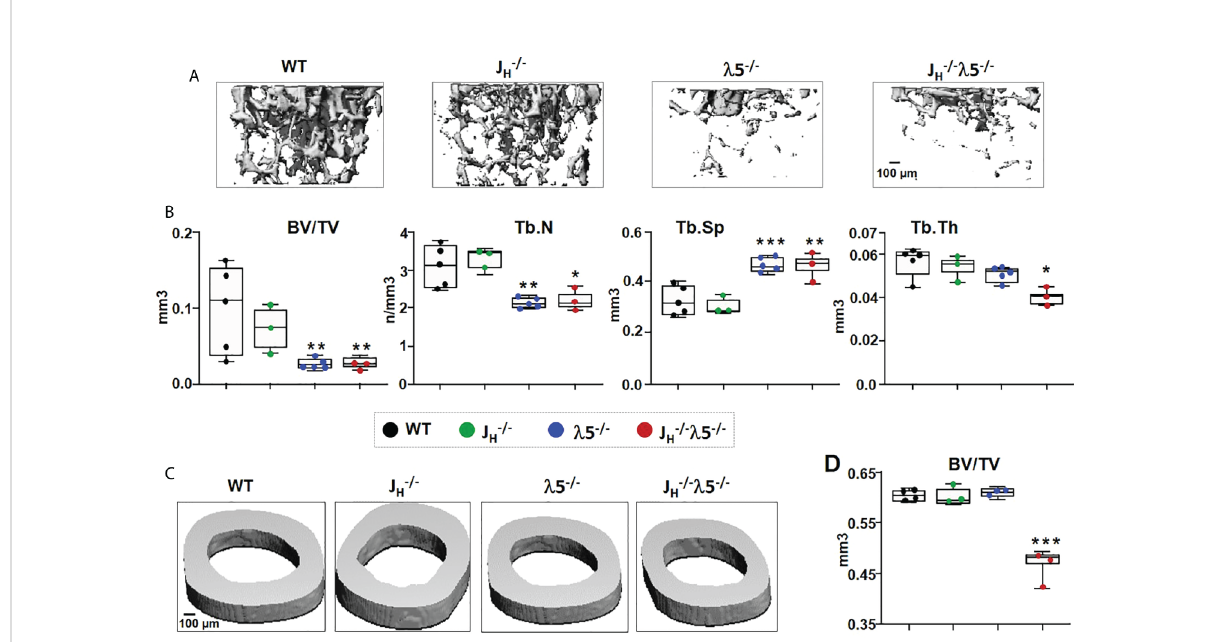
FIGURE 1 De fi ciency of l 5 and/or B cells decreases adult bone mass. (A) Representative µCT images of trabecular bone beneath the femoral growth plate and (C) cortical bone at the mid-diaphysis from the six-month old WT, J H-/- l 5 -/- and J H-/- l 5 -/- BALB/c female mice. (B) Quanti fi cation of the data from each genotype used to determine the bone parameters; ratio of trabecular bone volume to tissue volume (BV/TV), trabecular numbers (Tb.N), trabecular spacing (Tb.Sp), and trabecular thickness (Tb.Th). (D) The ratio of cortical bone volume to tissue volume (BV/TV) for each genotype. Data presented are pooled from n=3-5 mice per group. Statistical signi fi cance relative to WT mice was calculated by ANOVA. *p<0.05, **p<0.01, ***p<0.001. Scale bar: